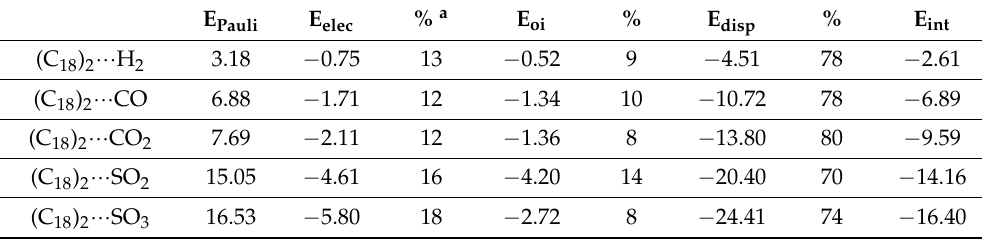
Table 6. EDA/BLYP-D3/ZORA/TZ2P decomposition of the interaction energy of complexes into Pauli repulsion (E Pauli ), electrostatic (E elec ), orbital interaction (E oi ) and dispersion (E disp ) components. All energies in